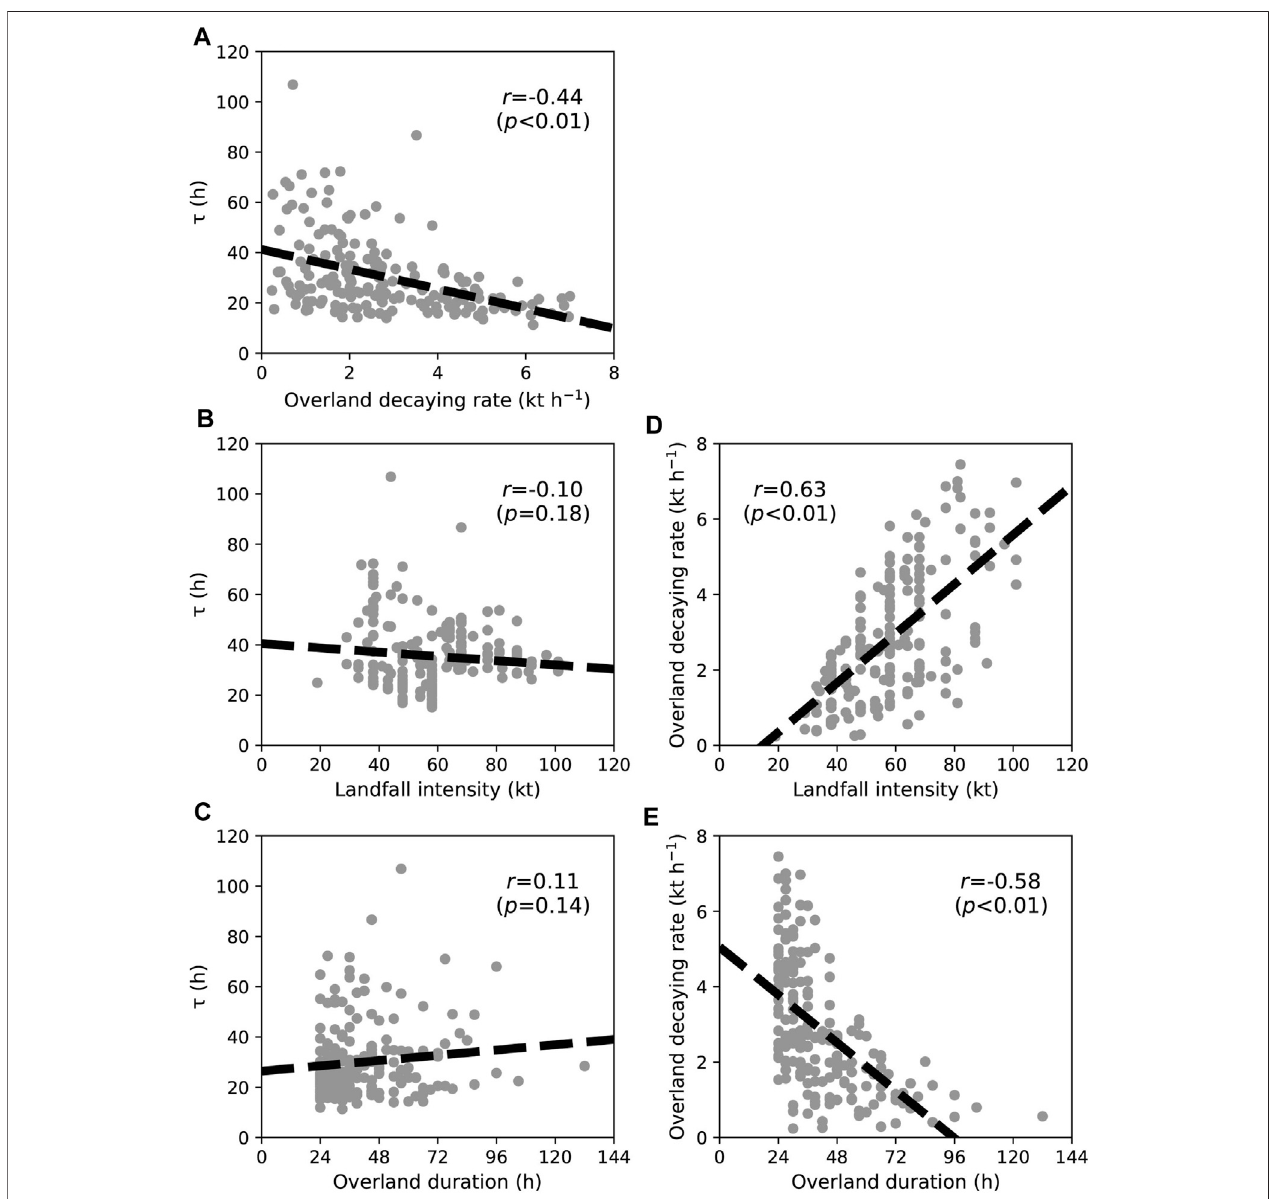
FIGURE 2 | Relationship of τ versus (A) overland decaying rate, (B) landfall intensity, (C) overland duration and relationship of overland decaying rate versus (D) landfall intensity, and (E) overland duration. The dashed lines are obtained by least squares, while the correlation coef fi cients and their signi fi cance levels are given in the